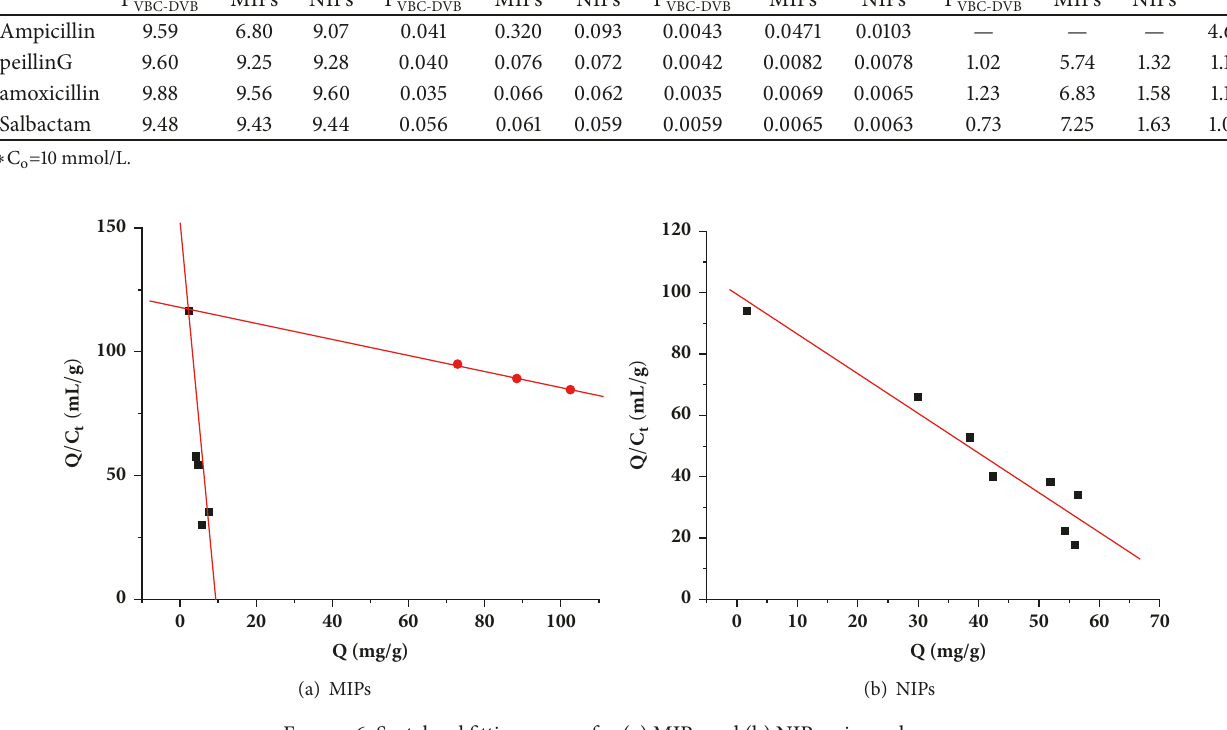
Table 3: Selective coefficients of MIPs, NIPs, and P